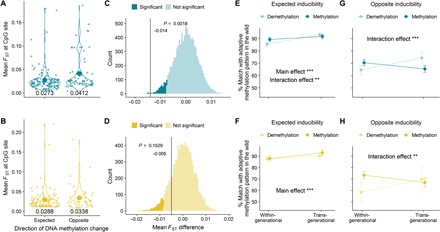
The duration of acclimation (within-generational versus transgenerational) and level of genomic differentiation between populations influence DNA methylation at inducible sites.(A and B) Mean FST values for inducible pop-DMS (with a ± 5-kb window) under experimental salinity decrease (top; blue) and increase (bottom; yellow) that shifted methylation levels toward the values observed in either the field (expected) or the opposite direction (opposite). A randomization test (with 10,000 bootstraps) was performed for the difference between expected and opposite mean FST value (δ.mean.FST = expected mean FST – opposite mean FST) (C and D). Under the one-tailed hypothesis of increased genetic differentiation at opposite sites and an α of 0.05, the P value was calculated as values smaller than the true difference divided by 10,000 bootstraps. In (E to H), the y axis shows the percentage match between the within- and transgenerational acclimation groups in relation to the methylation differentiation level found in natural populations at inducible pop-DMS. This value was obtained by calculating the difference between the methylation change in the experiment (meth.diff.exp in %; control versus within-generational or control versus transgenerational) and the difference in methylation between natural populations (meth.diff.wild in %) as δ.meth.diff = 100 − (meth.diff.wild − meth.diff.exp). Mean values ± 95% confidence interval are shown for within- and transgenerational acclimation to decreased and increased salinity at expected and opposite inducible sites. Colors refer to the direction of DNA methylation change (hypomethylation or hypermethylation). Values closer to 100 indicate a shift in methylation pattern toward adaptive methylation levels found in natural populations, and asterisks indicate the significance level (***P ≤ 0.001 and **P ≤ 0.01) for the comparison between within- and transgenerational acclimation. “Main effect” refers to an effect of acclimation (within- or transgenerational), and “interaction effect” refers to an interaction of acclimation and methylation direction (hypo- or hypermethylation).